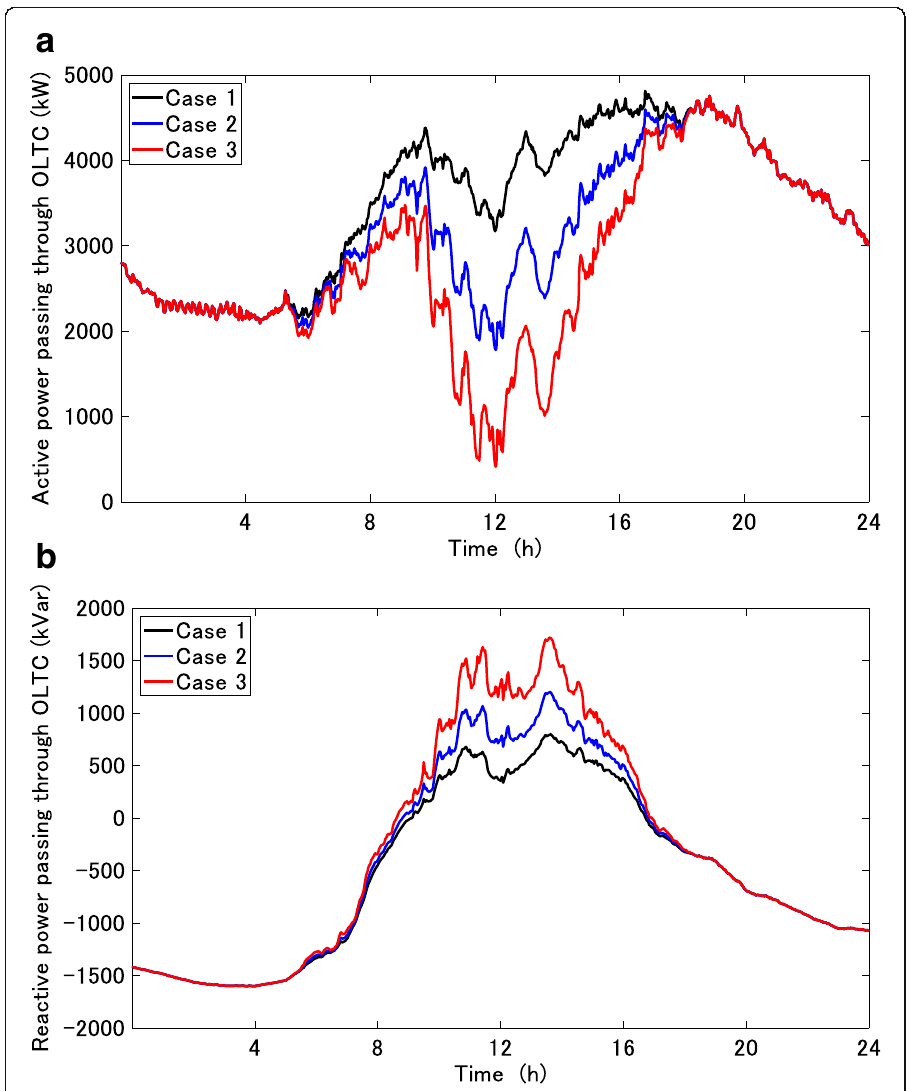
Fig. 12 A . Active power passing through the OLTC. B . Reactive power passing through the